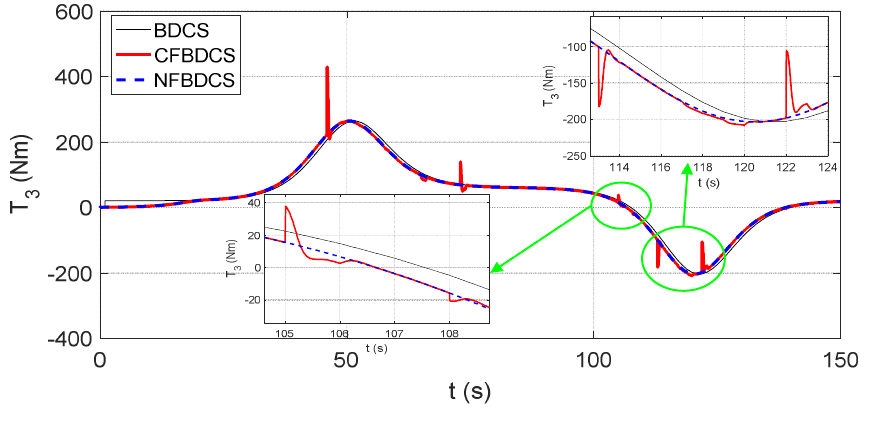
Figure 19. Total driving torque in the driving cycle.